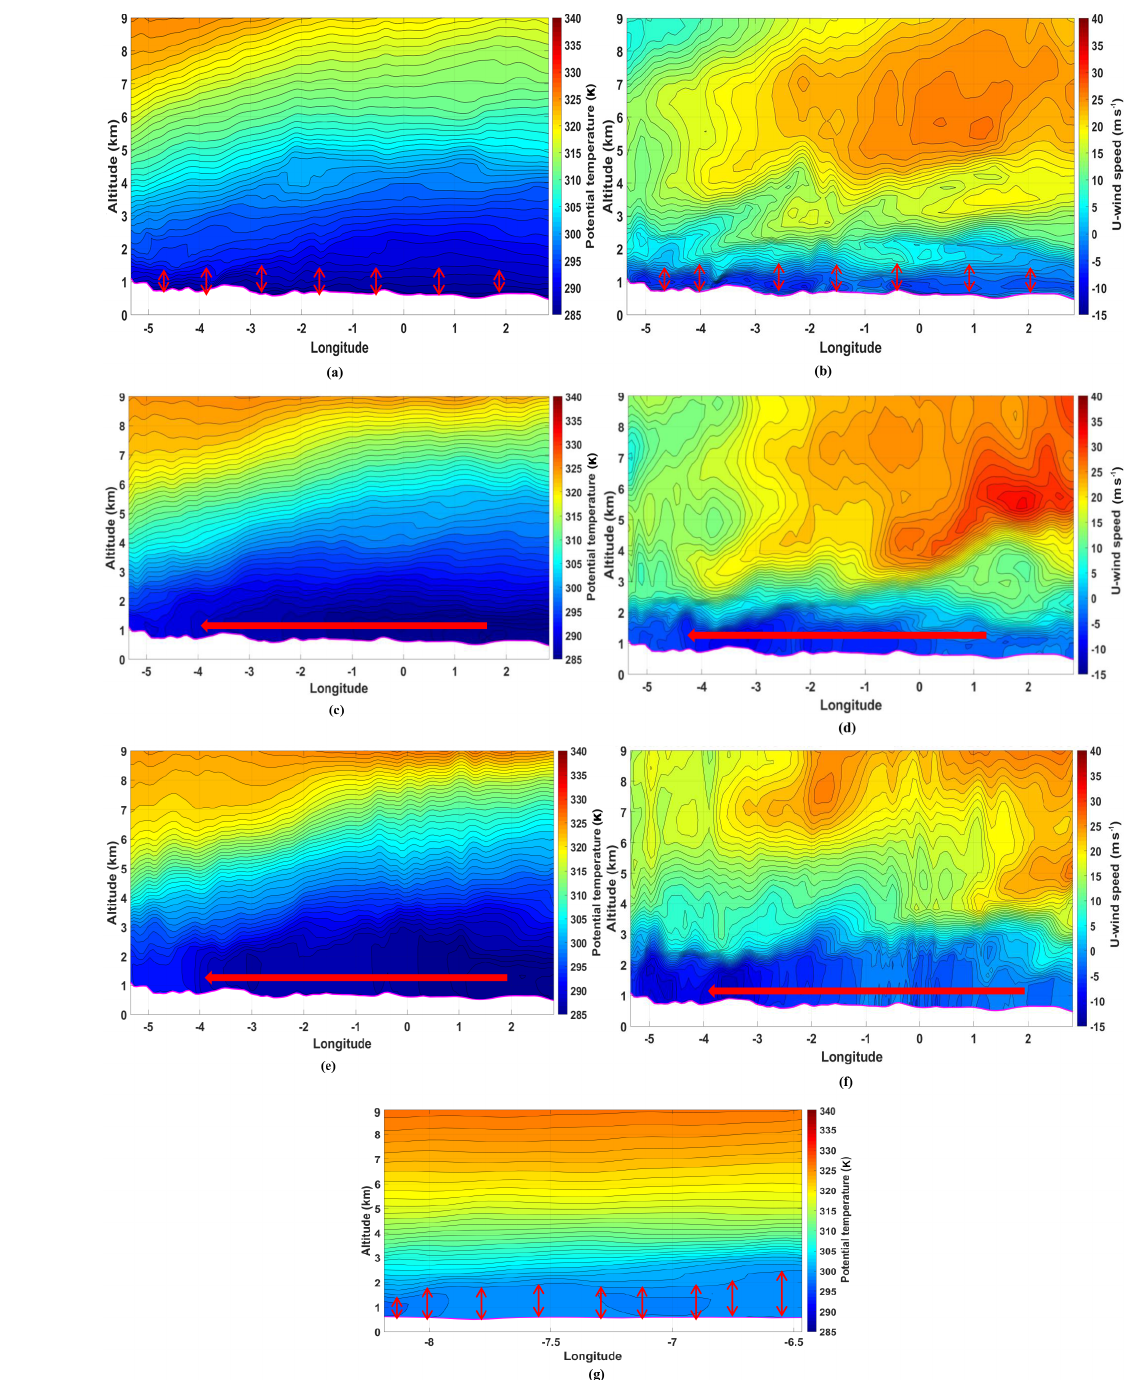
Figure 7. (a) Vertical cross sections of potential temperature at 31.1 ◦ N on 07:00UTC 2 March 2004 (6km resolution WRF product). Red arrows (up and down) indicate region of sinking of air column (blocking of air). (b) Vertical cross sections of u -wind speed at 31.1 ◦ N on 07:00UTC 2 March 2004 (6km resolution WRF product). Red arrows (up and down) indicate region of blocking of air. (c) Vertical cross sections of potential temperature at 31.1 ◦ N on 11:00UTC 2 March 2004 (6km resolution WRF product). Red arrow indicates generation of Kelvin waves (cold air surge). (d) Vertical cross sections of u -wind speed component at 31.1 ◦ N on 11:00UTC 2 March 2004 (6km resolution WRF product). Red arrow indicates generation of Kelvin waves. (e) Vertical cross sections of potential temperature at 31.1 ◦ N on 15:00UTC 2 March 2004 (6km resolution WRF product). Red arrow indicates Kelvin wave (cold air surge) over time. (f) Vertical cross sections of u -wind speed at 31.1 ◦ N on 15:00UTC 2 March 2004 (6km resolution WRF product). Red arrow indicates Kelvin wave over time. (g) Vertical cross sections of potential temperature at 28.85 ◦ N on 15:00UTC 2 March 2004 (6km resolution WRF product). Red arrows (up and down) indicate warm air column of vertical stretch of isentropes. Earth Syst. Dynam., 10, 651–666, 2019